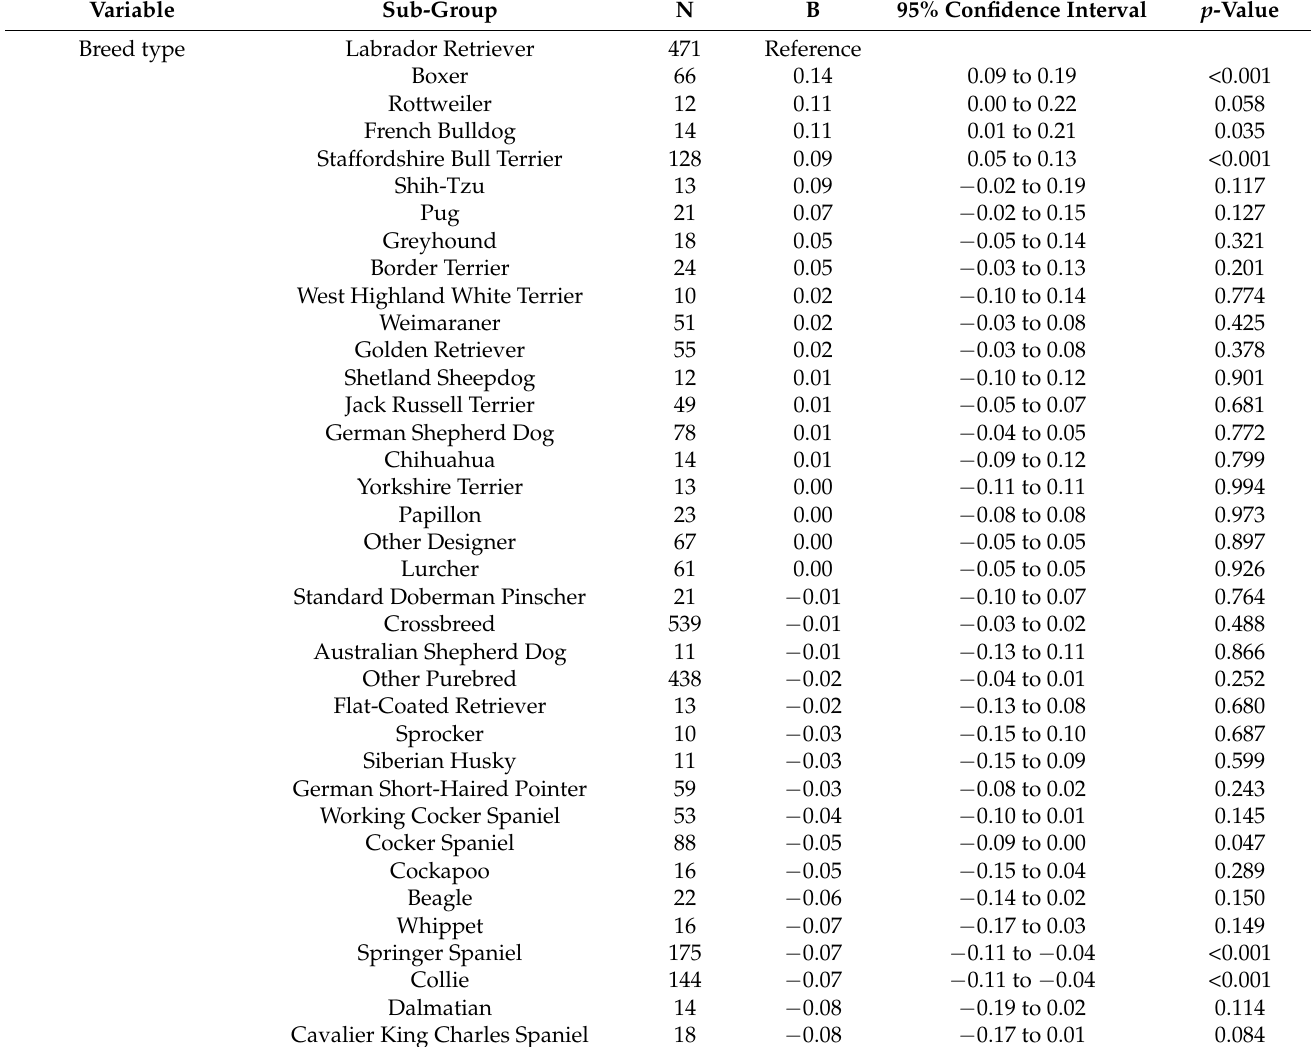
Table A2. Univariable linear regression results for breed type association with summer weather effects on canine activity scores. Sub-groups with a positive B value increased the winter weather effects score and sub-groups with a negative B value decreased the winter effects